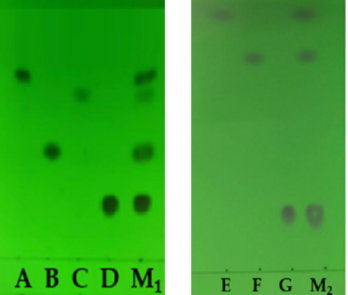
Figure 1. TLC of the seven pesticides and their mixture solution. (A, B, C, D, E, F, and G: Abamectin, Methomyl, Carbendazim, Imidacloprid, Chlorothalonil, Azoxystrobin, and Acetamiprid, respectively. M 1 : Mixture solution of A, B, C, and D. M 2 : Mixture solution of E, F, and